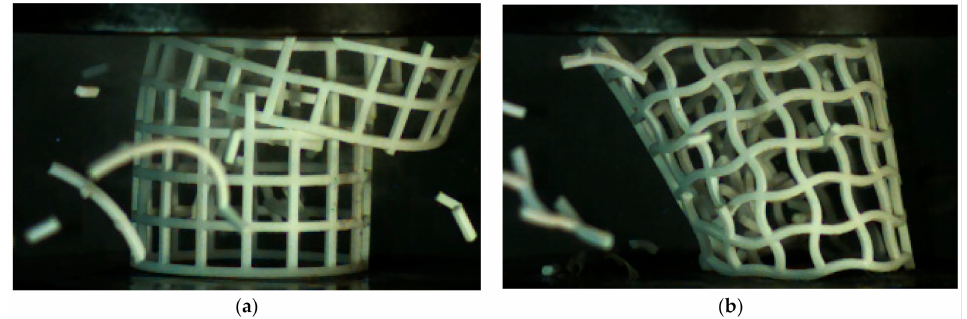
Figure 20. ( a ) CCHT0 at the displacement of 60 mm under dynamic test. ( b ) CCHT1 at the displace- ment of 60 mm under dynamic